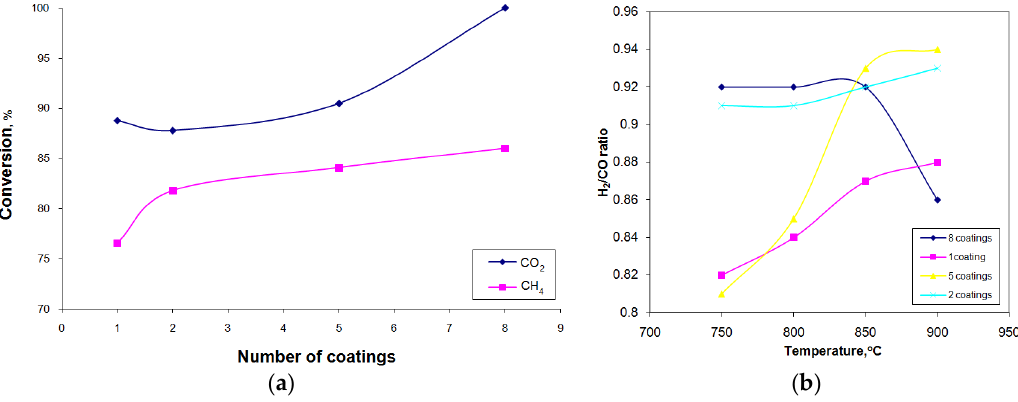
Figure 8. Influence of ( a ) number of coatings (gun passes) during CAFSY on the conversion of CH 4 andCO 2 ; and ( b ) temperature of catalysis on the H 2 /CO ratio in the outlet gases.